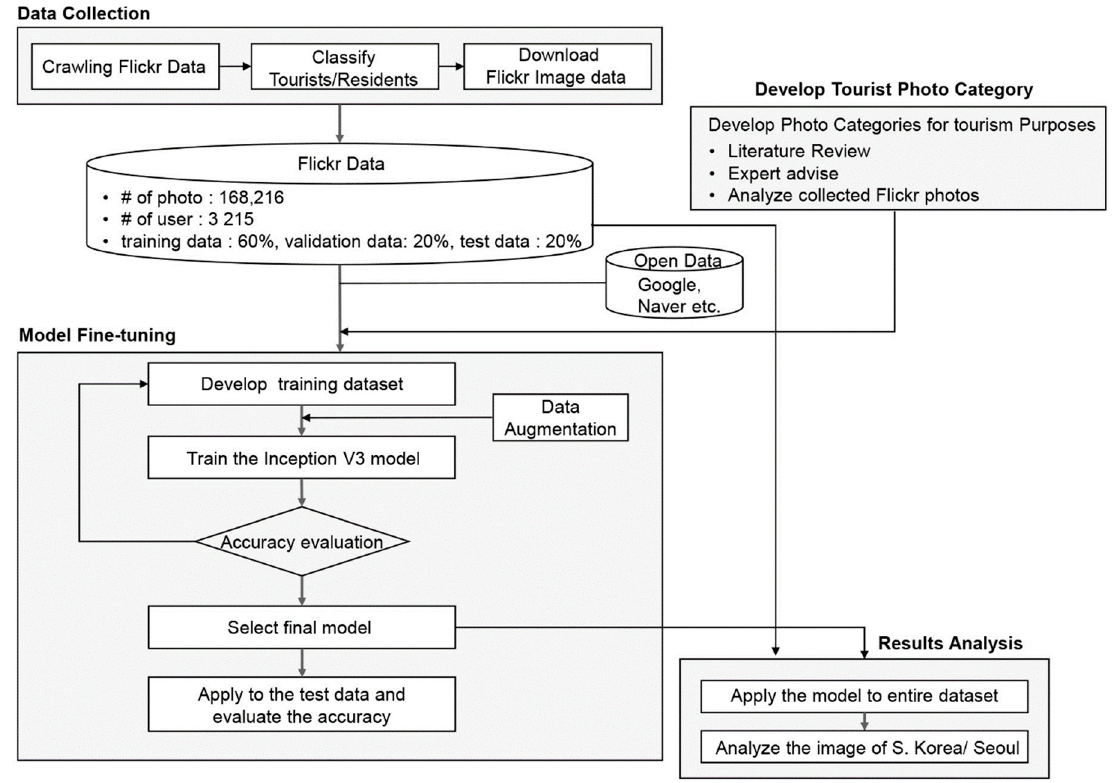
Figure 1. Research process.